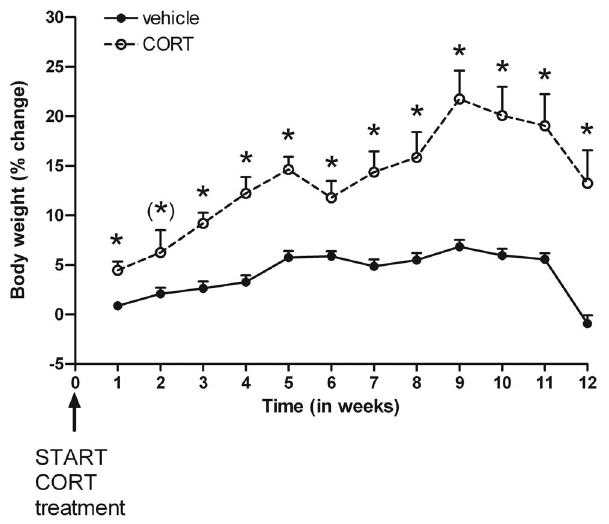
Figure 6. Effects of corticosterone (CORT) administration via the drinking water upon water intake (mean % change + S.E.M.) during the 12 week treatment period. Significant increased amounts of water intake in the CORT group are denoted with *( P , 0.01).